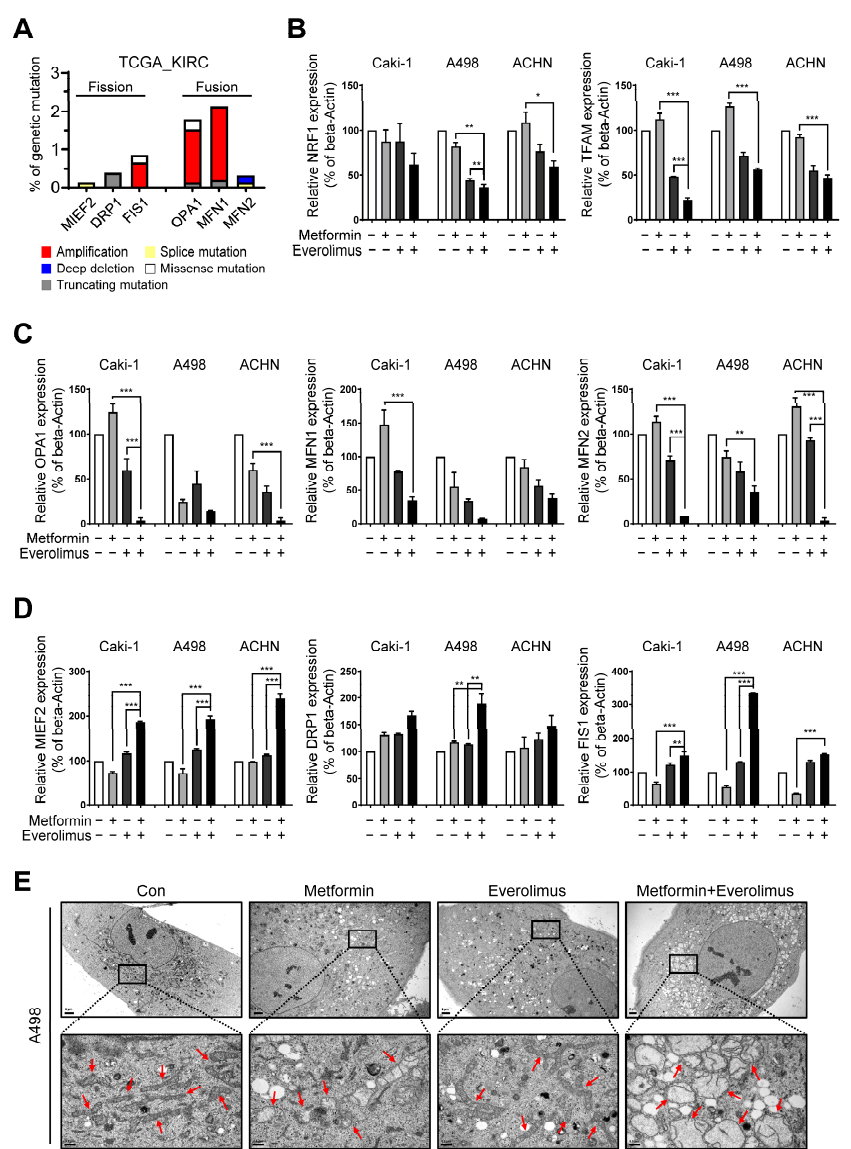
Figure 3. Combination treatment regulates mitochondrial dynamics: ( A ) Several mitochondrial fusion-fission-related genes presented the amplification mutation based on the TCGA-KIRC data; ( B – D ) qRT-PCR for ( B ) mitochondrial biosynthesis-related genes, ( C ) fusion marker genes, and ( D ) fission marker genes in the Caki-1, A498, and ACHN cells treated with the control, metformin, everolimus, and drug combination; ( E ) Representative TEM images of mitochondria (indicated with red arrows) in drug-treated A498 cells. Bar: 2 µm (upper) and 0.5 µm (bottom). Data are presented as the mean ± standard error of the mean. * p < 0.05; ** p < 0.01; and *** p < 0.001 vs. combination treatment group of metformin and everolimus.